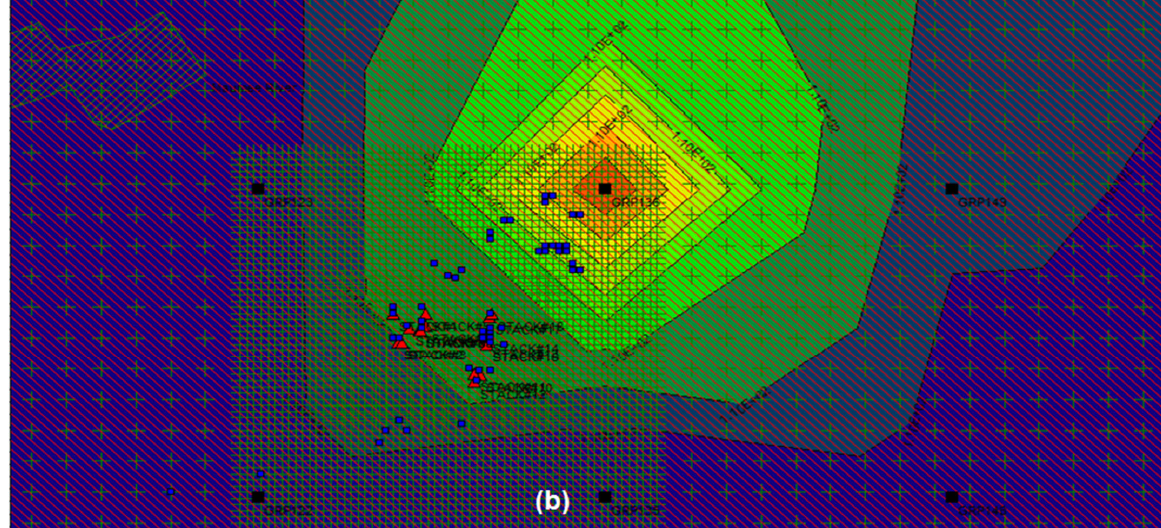
Figure 5. ( a ) Contour plot of the total hazard quotient for location 2. ( b ) Magnification of the area enclosed by white rectangle in ( a ).